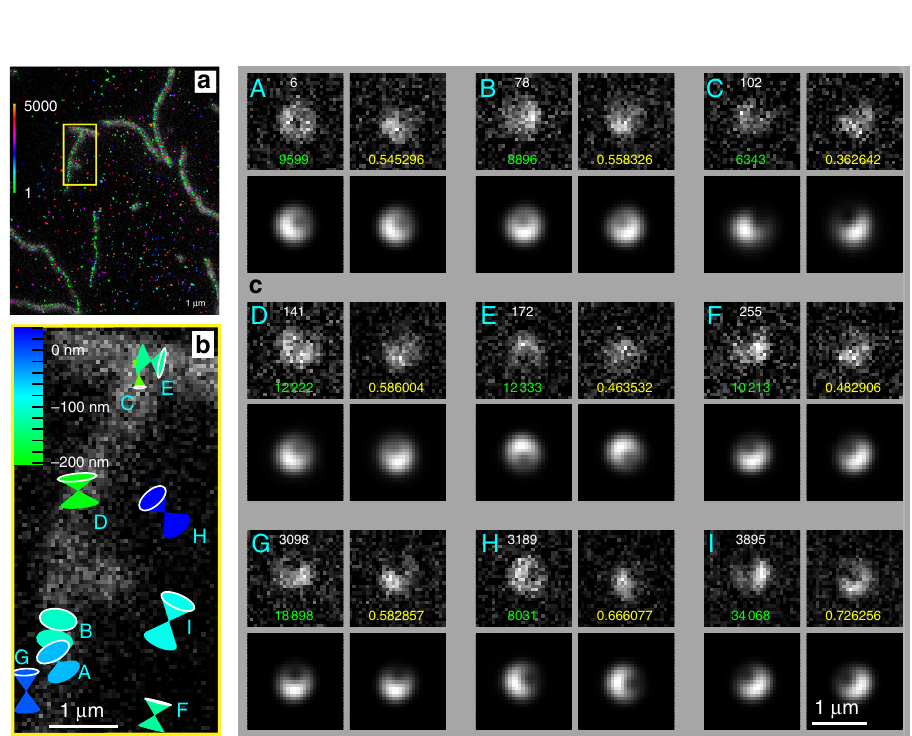
The standard deviationson the last column are weighted averages of the standard deviations for each molecule, with the exception for that in z , which is the weighted average of the standard deviations for each molecule of the increments in height.